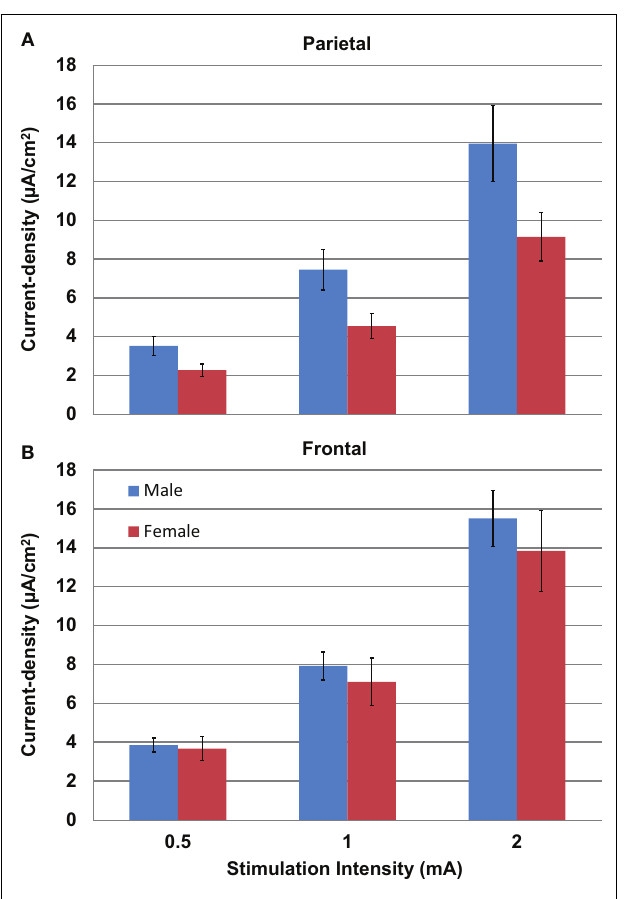
FIGURE 5 |Above are graphs of the mean current densities for the males (blue) and females (red) at the parietal locations [(A) top] and the frontal locations [(B) bottom] . Error bars represent ± standard error of the mean.